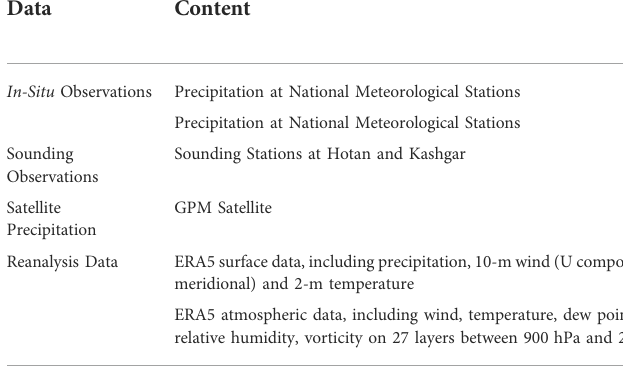
TABLE 1 Datasets used in this